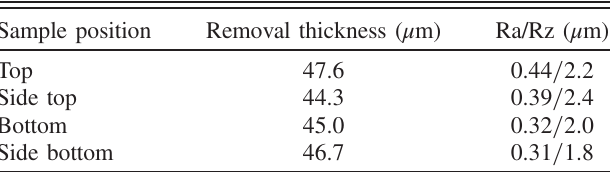
TABLE III. Removal thicknesses and surface roughness of the Nb samples EPed at 210